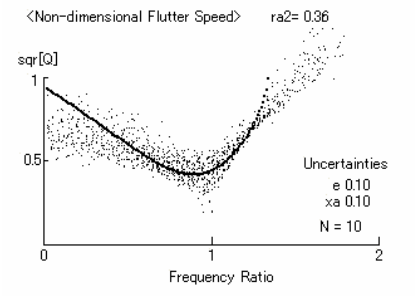
Fig 7. Boundary with a different radius of